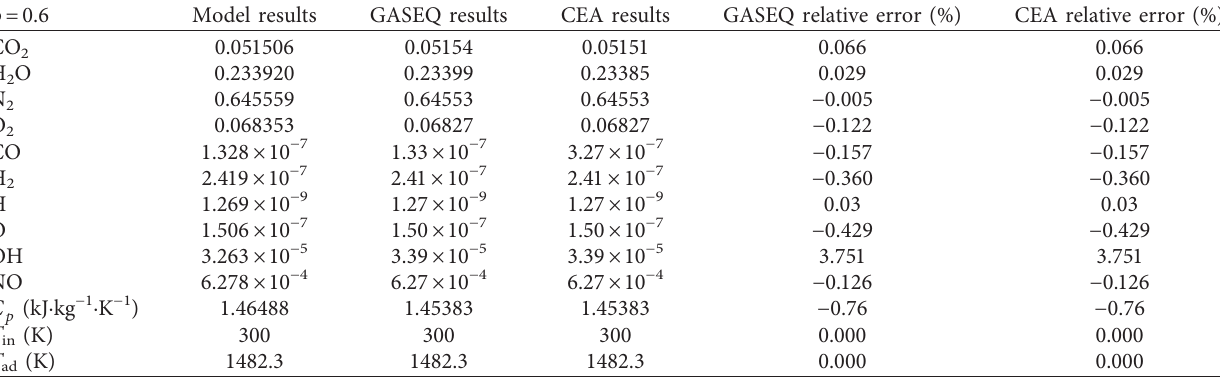
Table 5: Comparison of the present model results with the ones obtained from CEA of NASA and GASEQ software for equilibrium combustion products of methane at ϕ � 0.6 and steam injection 10%.